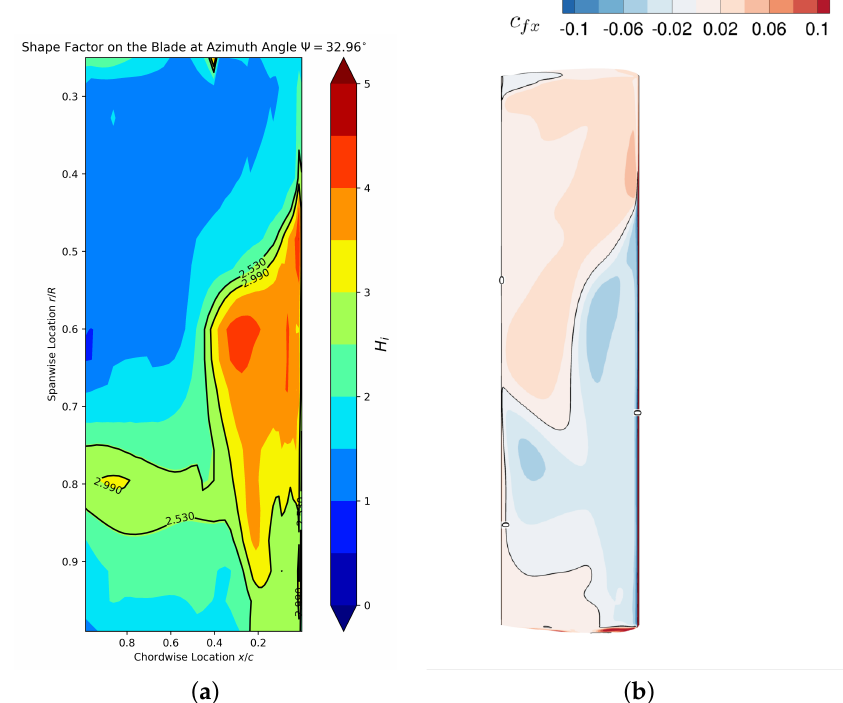
Figure 18. ( a ) Shape Factor H i on the upper surface at azimuth angle Ψ = 32.9 ◦ , two contour lines indicate the upper and lower bound of H i value to determine the separation; ( b ) skin friction c fx on the upper surface at azimuth angle Ψ = 32.9 ◦ , the 0 contour line showing the separation